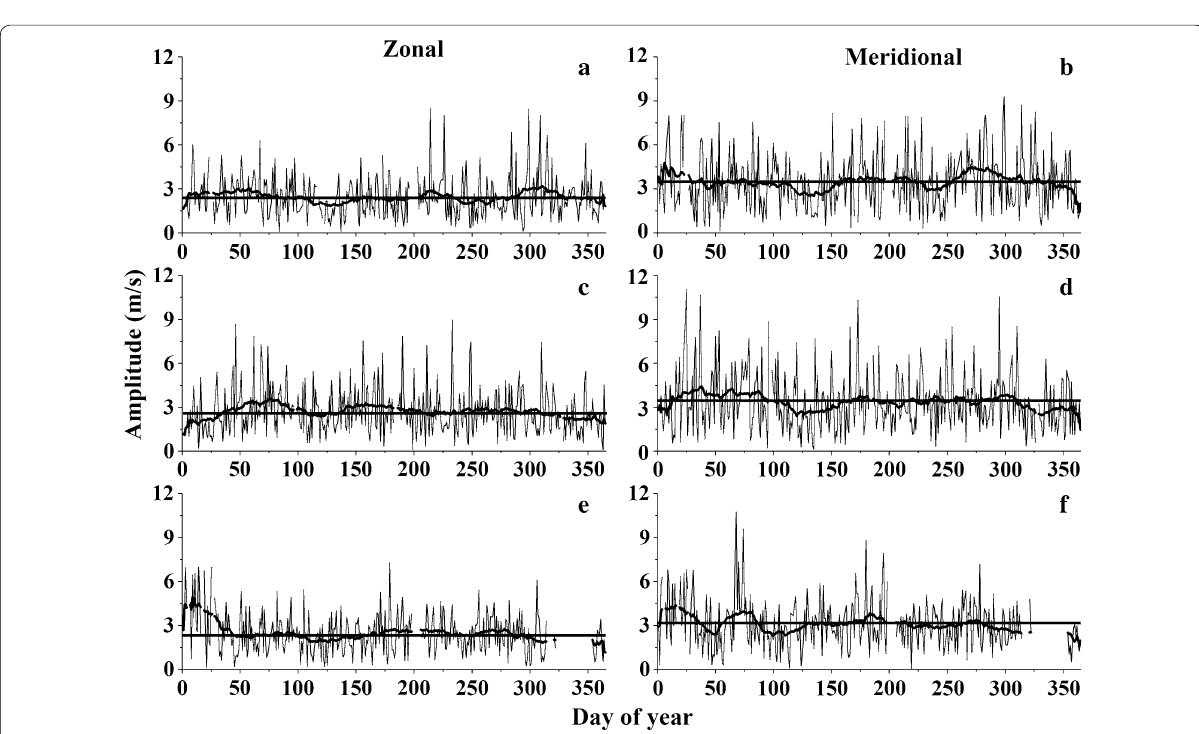
Fig. 3 Vertically (81–99 km) averaged daily QDT amplitude in 2005 for the a zonal wind at CA, b meridional wind at CA, c zonal wind at CP, d meridional wind at CP, e zonal wind at SM, and f meridional wind at